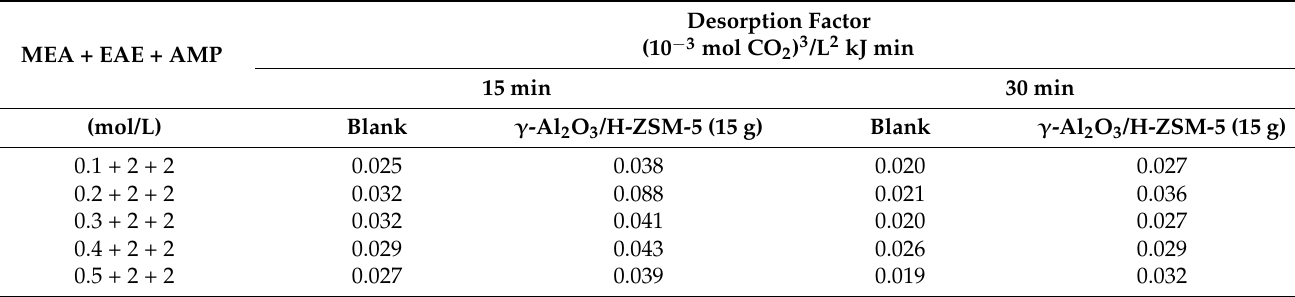
Table 2. The desorption factors of tri-solvent of MEA + EAE + AMP solvents with various catalysts: 15 min and 30